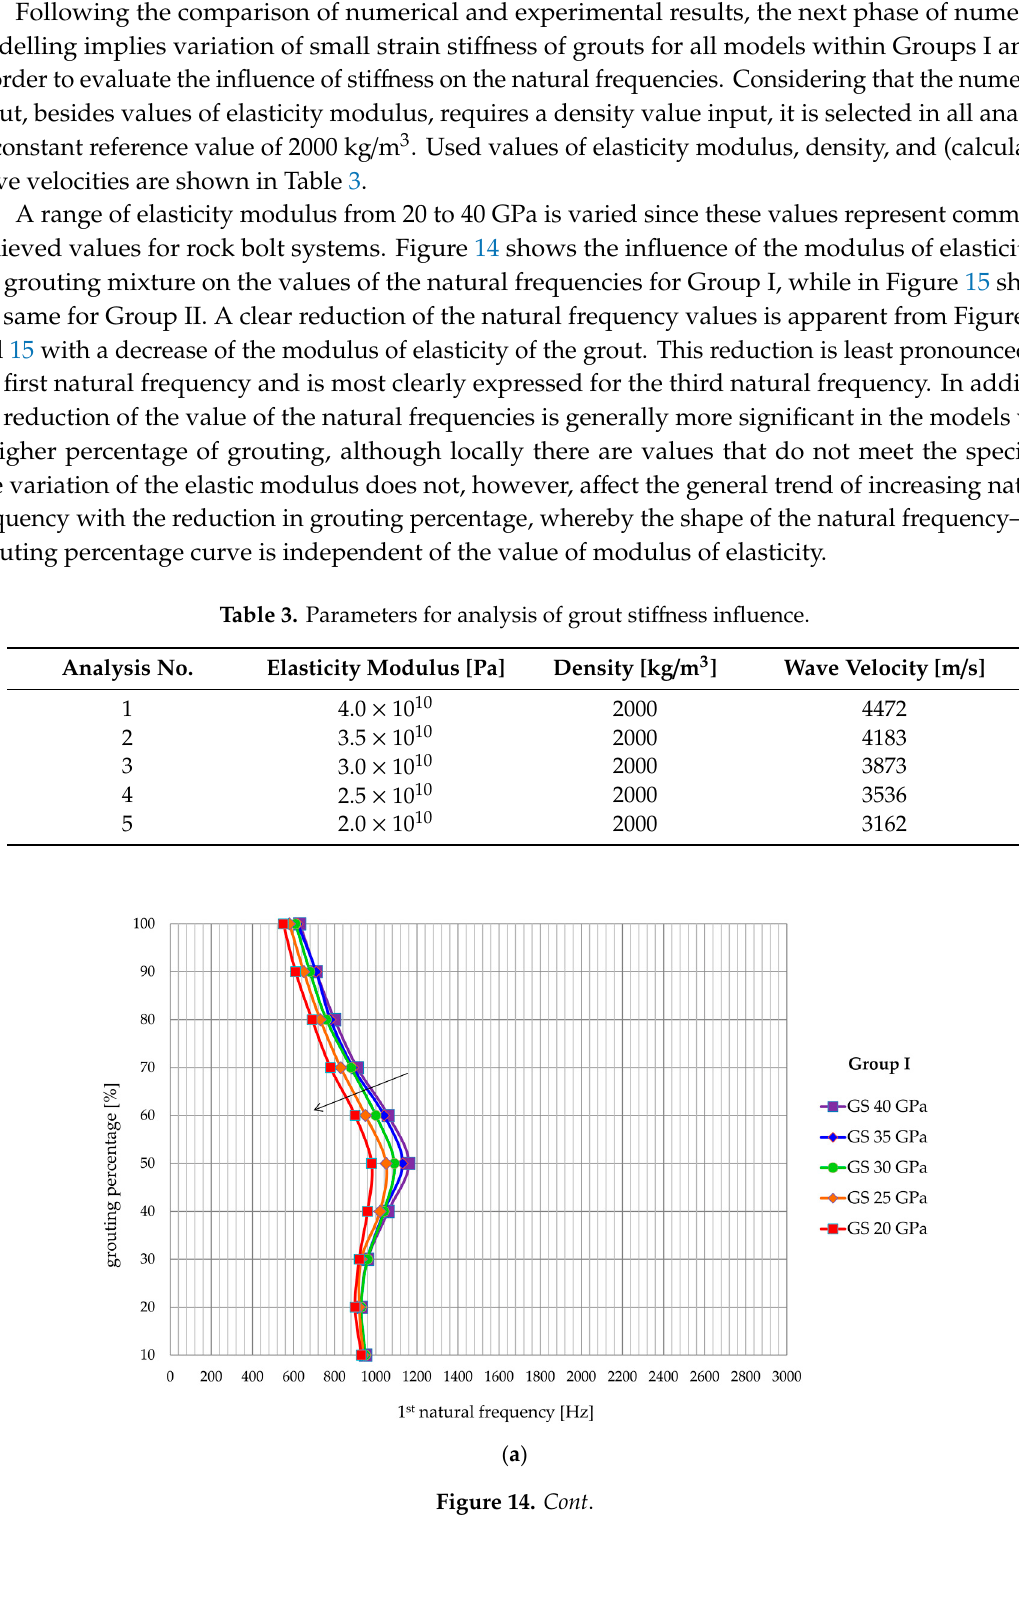
Table 3. Parameters for analysis of grout stiffness influence.